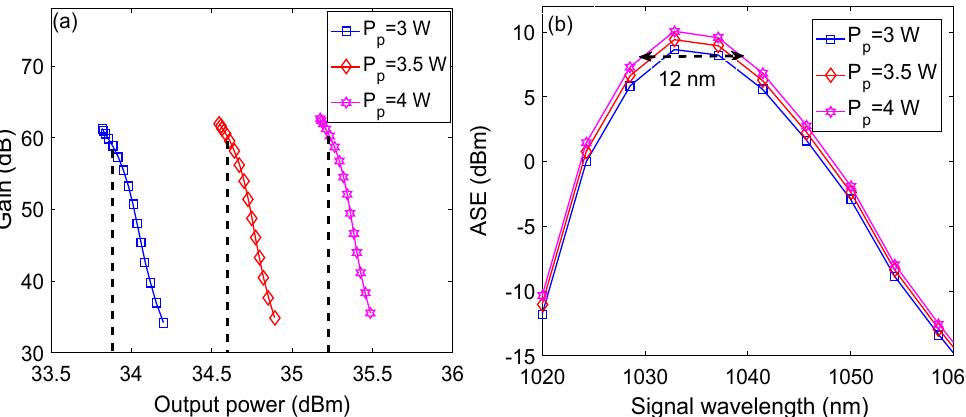
Figure 9. ( a ) Output power versus gain plots as a function of pump power; ( b ) signal wavelength versus ASE plots as a function of pump power.